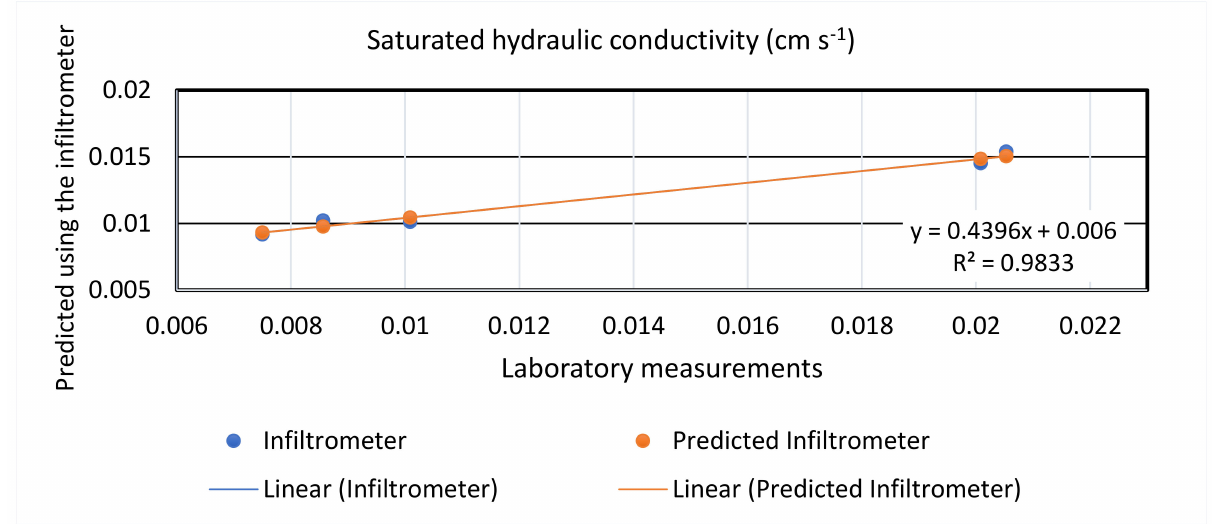
Figure 6. Validation of the method for saturated hydraulic conductivity, K s , comparison between laboratory measurements and predictions based on infiltration experiments. black circles represent the mean